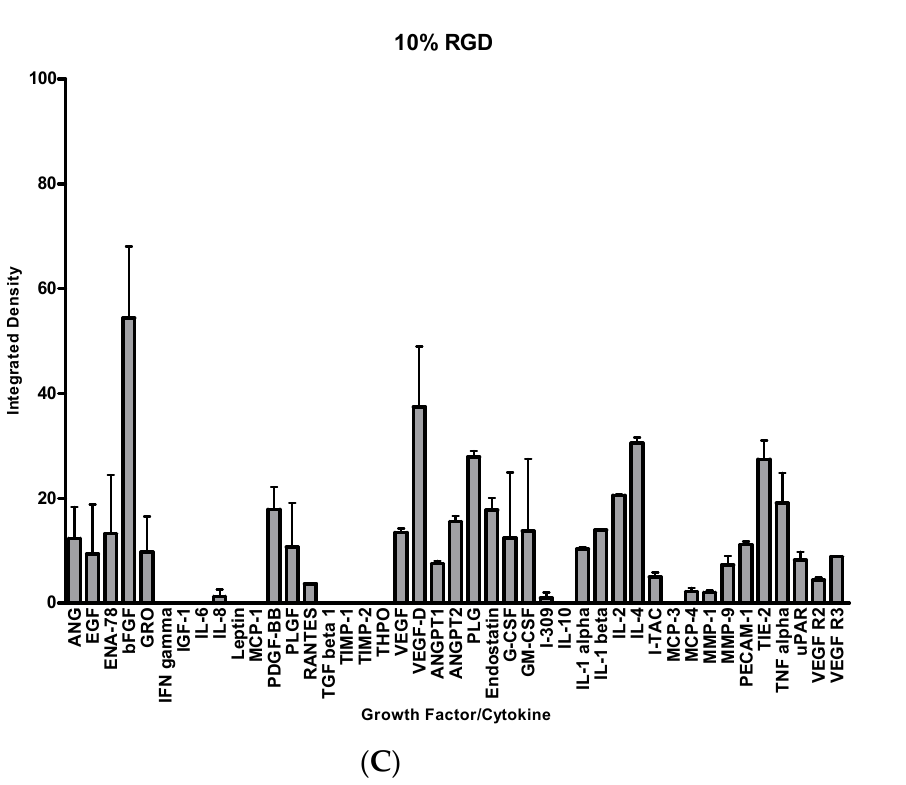
Figure 4. Growth factors/cytokine expression in conditioned media from DPSCs in ( A ) 2D culture or following 14-day encapsulation in ( B ) 0% RGD or ( C ) 10% RGD hydrogels. Abbreviations: angiogenin (ANG); epidermal growth factor (EGF); epithelial neutrophil-activating peptide 78 (ENA-78); basic fibroblast growth factor (bFGF); growth-regulated alpha protein (GRO- α ); interferon gamma (IFN- γ ); insulin-like growth factor 1 (IGF-1); interleukin-6 (IL-6); interleukin-8 (IL-8); leptin; monocyte chemoattractant protein-1 (MCP-1); platelet-derived growth factor BB (PGDF-BB); placental growth factor (PLGF); regulated upon activation normal T cell expressed and secreted (RANTES); transforming growth factor- beta 1 (TGF- β 1); tissue inhibitor of matrix metalloproteinases-1 (TIMP-1); tissue inhibitor of matrix metalloproteinases-2 (TIMP-2); thrombopoietin (THPO); vascular endothelial growth factor (VEGF); vascular endothelial growth factor- D (VEGF-D); angiopoietin-1 (ANGPT1); angiopoietin-2 (ANGPT2); plasminogen (PLG); endostatin; granulocyte colony stimulating factor (G-CSF); granulocyte-macrophage colony-stimulating factor (GM-CSF); T lymphocyte-secreted protein I-309 (I-309); interleukin-10 (IL-10); interleukin-1 alpha (IL-1 α ); interleukin-1 beta (IL-1 β ); interleukin-2 (IL-2); interleukin-4 (IL-4); interferon-inducible T cell alpha chemoattractant (I-TAC); monocyte chemoattractant protein-3 (MCP-3); monocyte chemoattractant protein-4 (MCP-4); matrix metalloproteinase-1 (MMP-1); matrix metalloproteinase-9 (MMP-9); platelet and endothelial cell adhesion molecule-1 (PECAM-1); tyrosine kinase with immunoglobulin-like and EGF-like domains (TIE-2); tumour necrosis factor alpha (TNF α ); urokinase plasminogen activator surface receptor (uPAR); vascular endothelial growth factor receptor 2 (VEGF R2); vascular endothelial growth factor receptor 3 (VEGF R3).